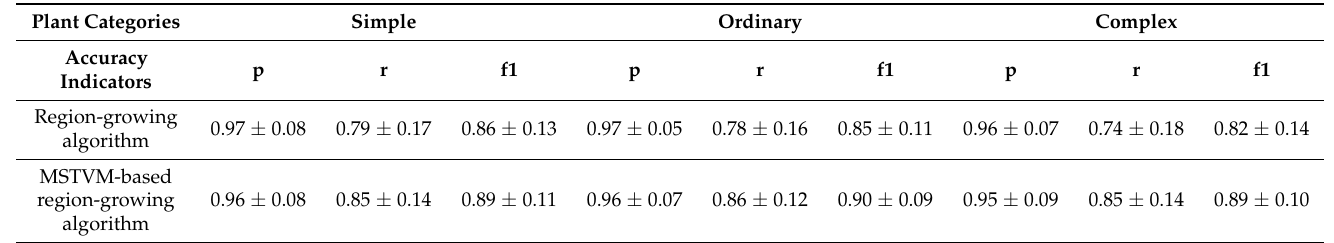
Table 1. The mean and standard deviation of precision, recall, and F1-Score values with region- growing algorithm and MSTVM-based region-growing